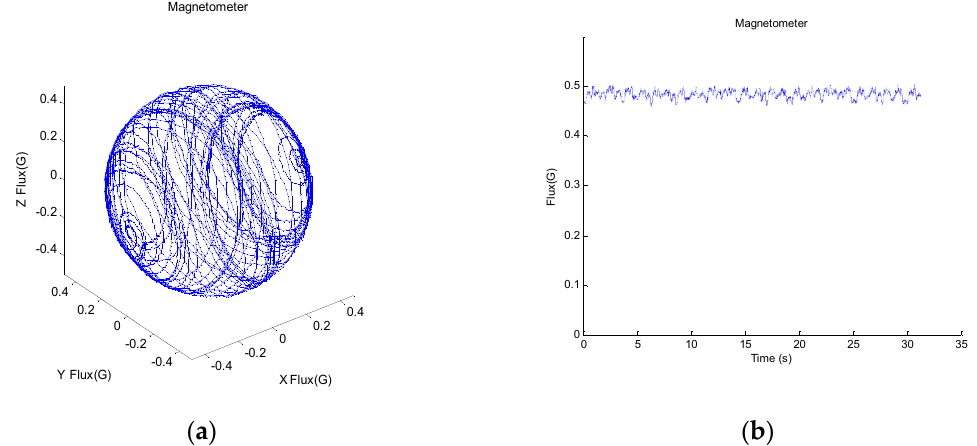
Figure 6. The magnetic field measured by a well calibrated MIMU. ( a ) The measured 3D magnetic field; ( b ) the magnitude of the magnetic field.